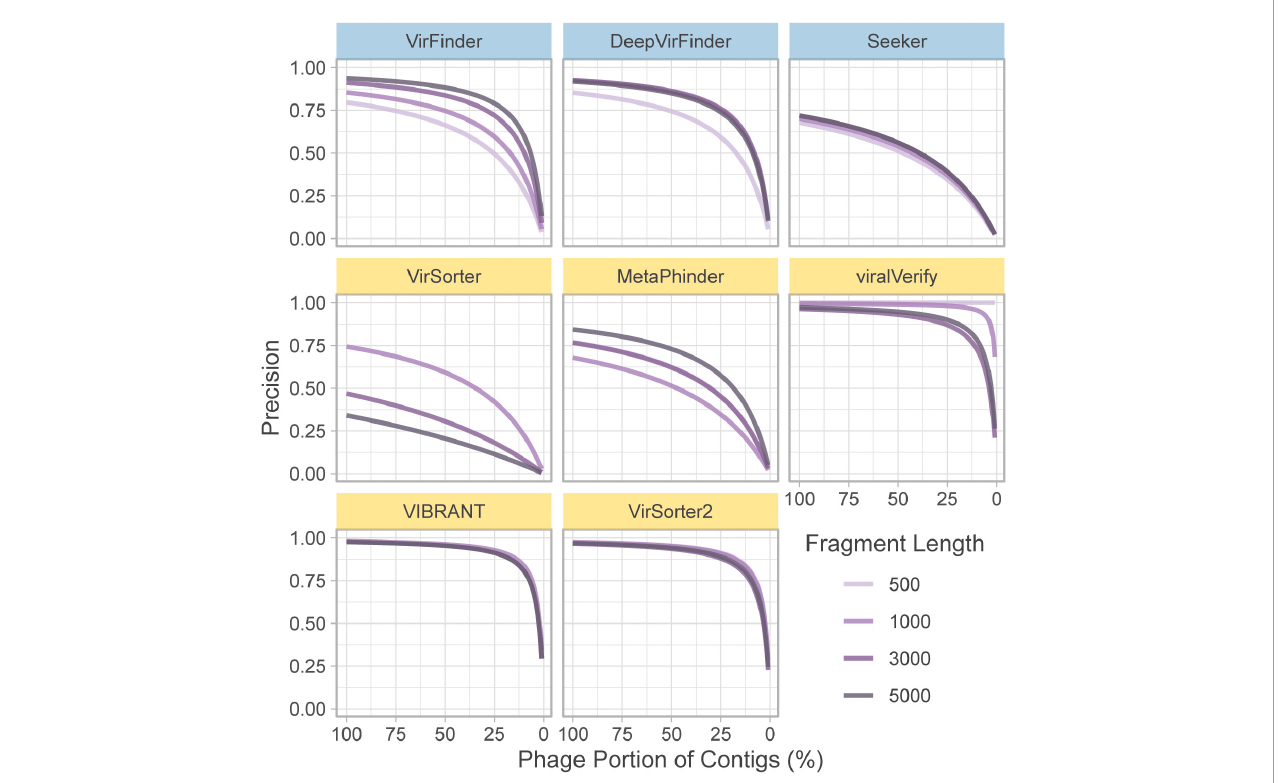
FIGURE3 Extrapolated precision calculated from FPR of each tool at four fragment lengths (500, 1,000, 3,000, and 5,000 nt). Precision is calculated for communities composed of varying levels of non-viral fragments from 0% (all phage) to 100% (all non-phage). Top row of tools are sequence-based (in blue), bottom two rows are homology-based (in